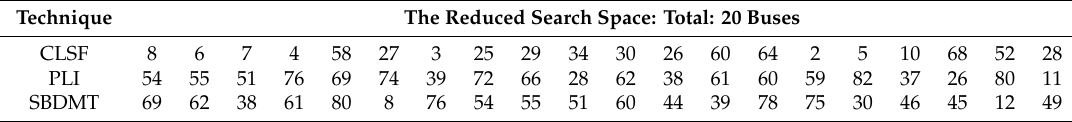
Table 10. The reduced search space by SBDMT comparing to CLSF and PLI for the 85-bus system. Technique The Reduced Search Space: Total: 20